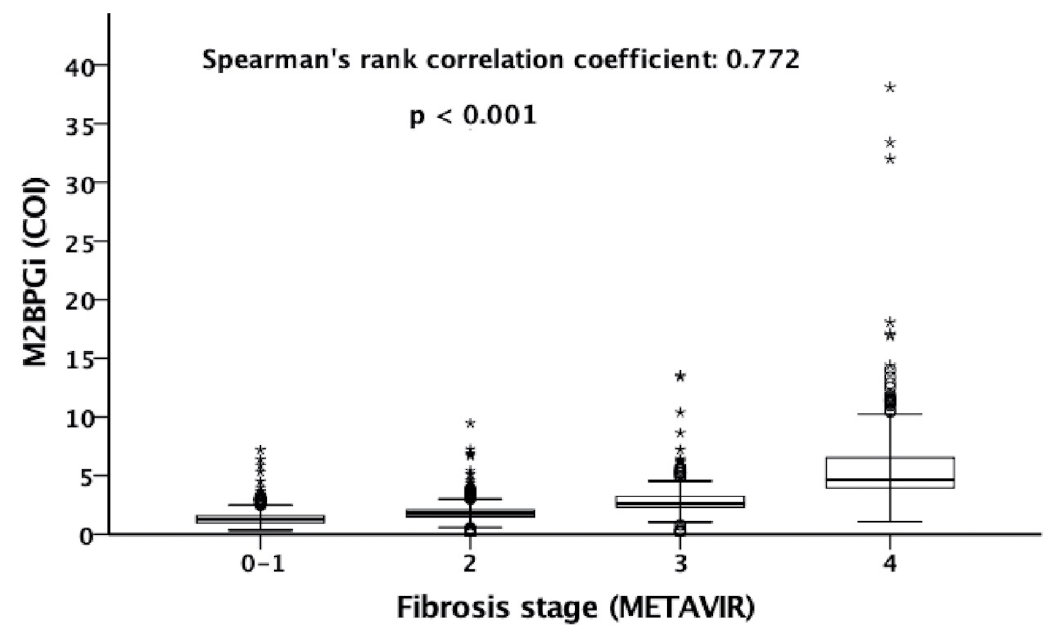
Figure 3. Box plots of serum M2BPGi level (COI) for METAVIR hepatic fibrosis F0–1, F2, F3, and F4 as categorized by LSM. The tops and bottoms of the boxes are the first and the third quartiles. The tops and bottoms of the horizontal lines are the upper and lower whiskers. The circles denote mild outliers and the asterisks denote extreme outliers. The Spearman’s rank correlation coefficient was 0.772 ( p < 0.001).